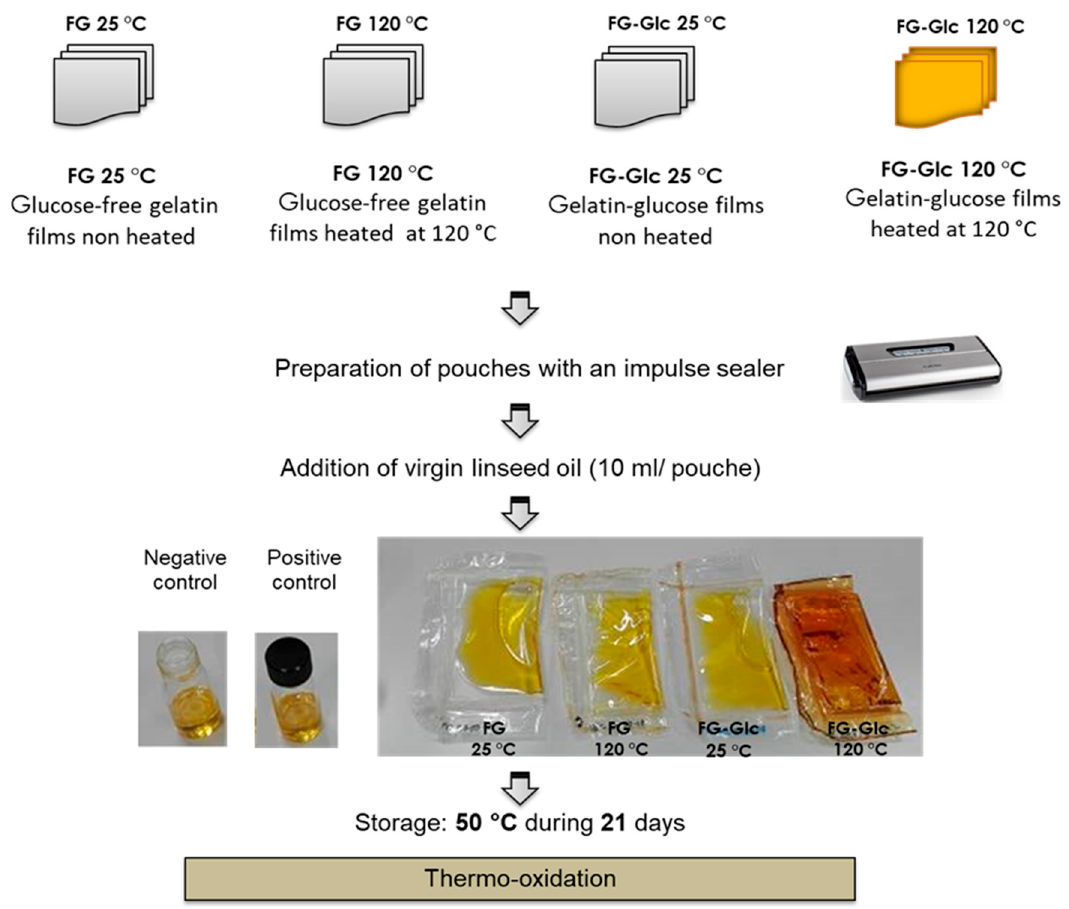
Figure 1. Packaging of flaxseed oil in glucose-free gelatin and gelatin-glucose pouches. FG: Fish gelatin film. FG-Glc: Glucose-Fish gelatin film.